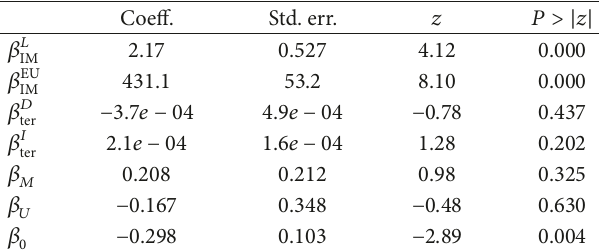
Table 2: Pooled time series cross-section (TSCS) analysis with Table 3: Pooled time series cross-section (TSCS) analysis with random-effects GLS regression. Test statistics: Wald 𝜒 2 (5) = 142.4 and Prob > 𝜒 2 = 0.000 .